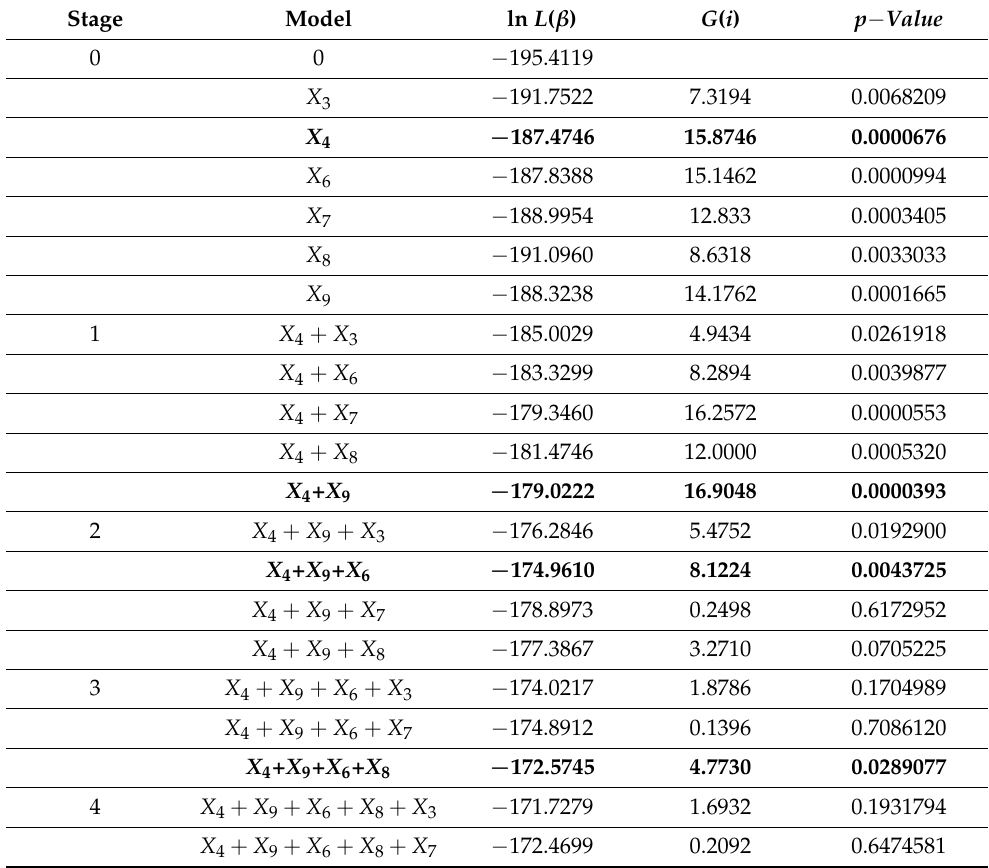
Table 11. Results of selection of the best Cox proportional hazard model.